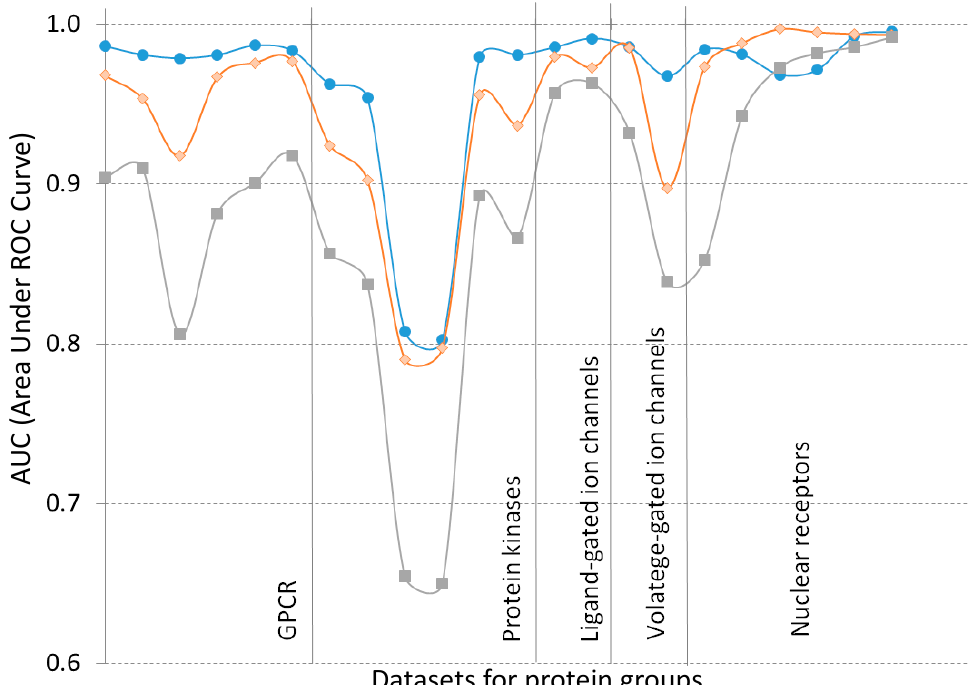
Figure 2. The accuracy prediction obtained for datasets related to five protein–ligand groups. Each point corresponds to the AUC value from Tables 2 and 3. The blue, orange, and gray curves are related to the first, second, and third scenario, respectively. Each AUC value equals to maximum of ones calculated at frames of 7 and 30.